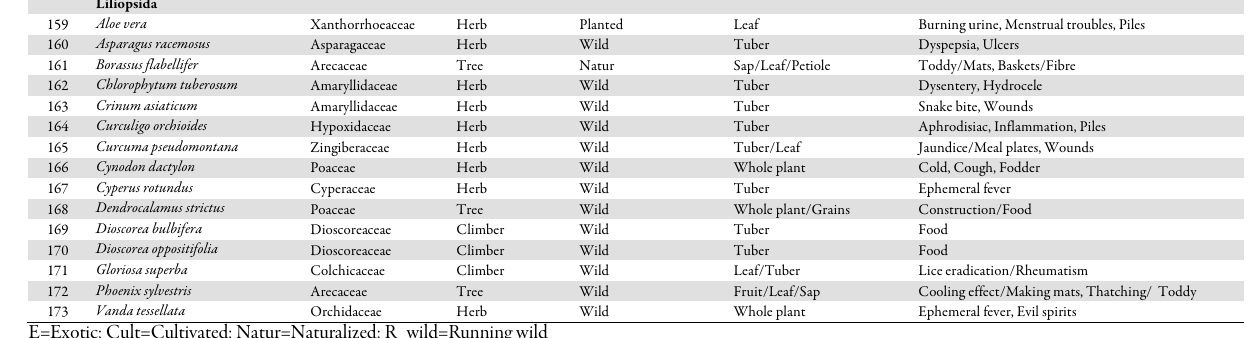
Table 2. Five top-rank angiosperm families used in Pocharam wildlife sanctuary No. crt.